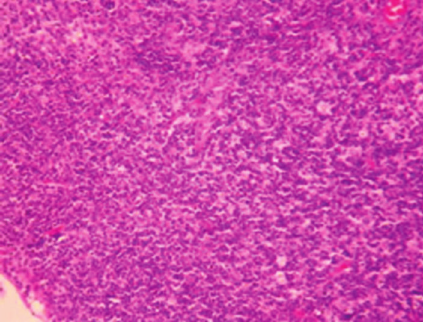
Figure 13: Treated group 28 days; normal lymph node; HE ×